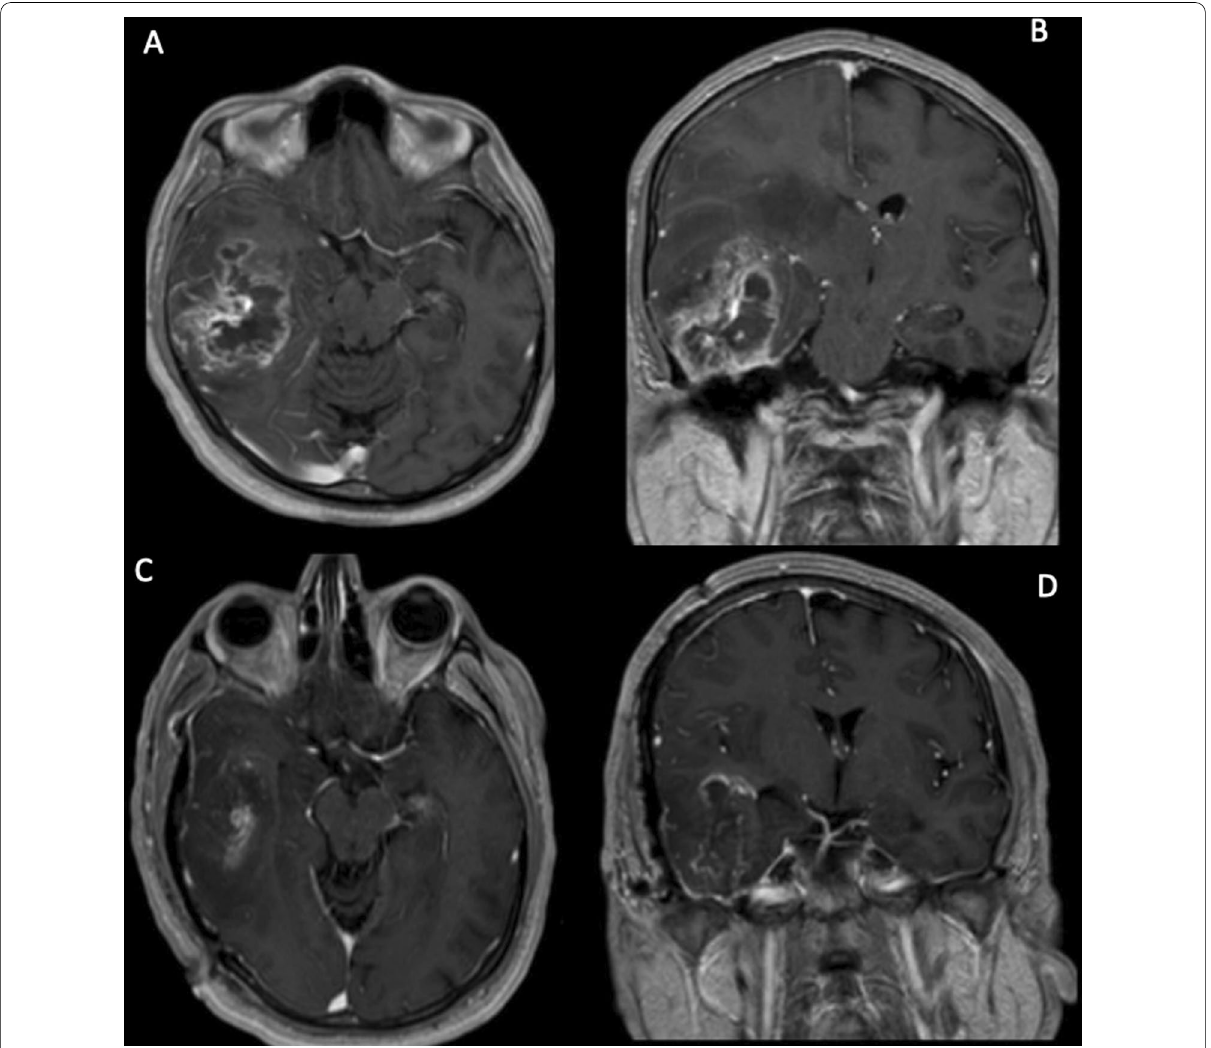
Fig. 1 Primary glioblastoma. A , B Preoperative axial and coronal cranial MRI scan. C , D Postoperative axial and coronal cranial MRI